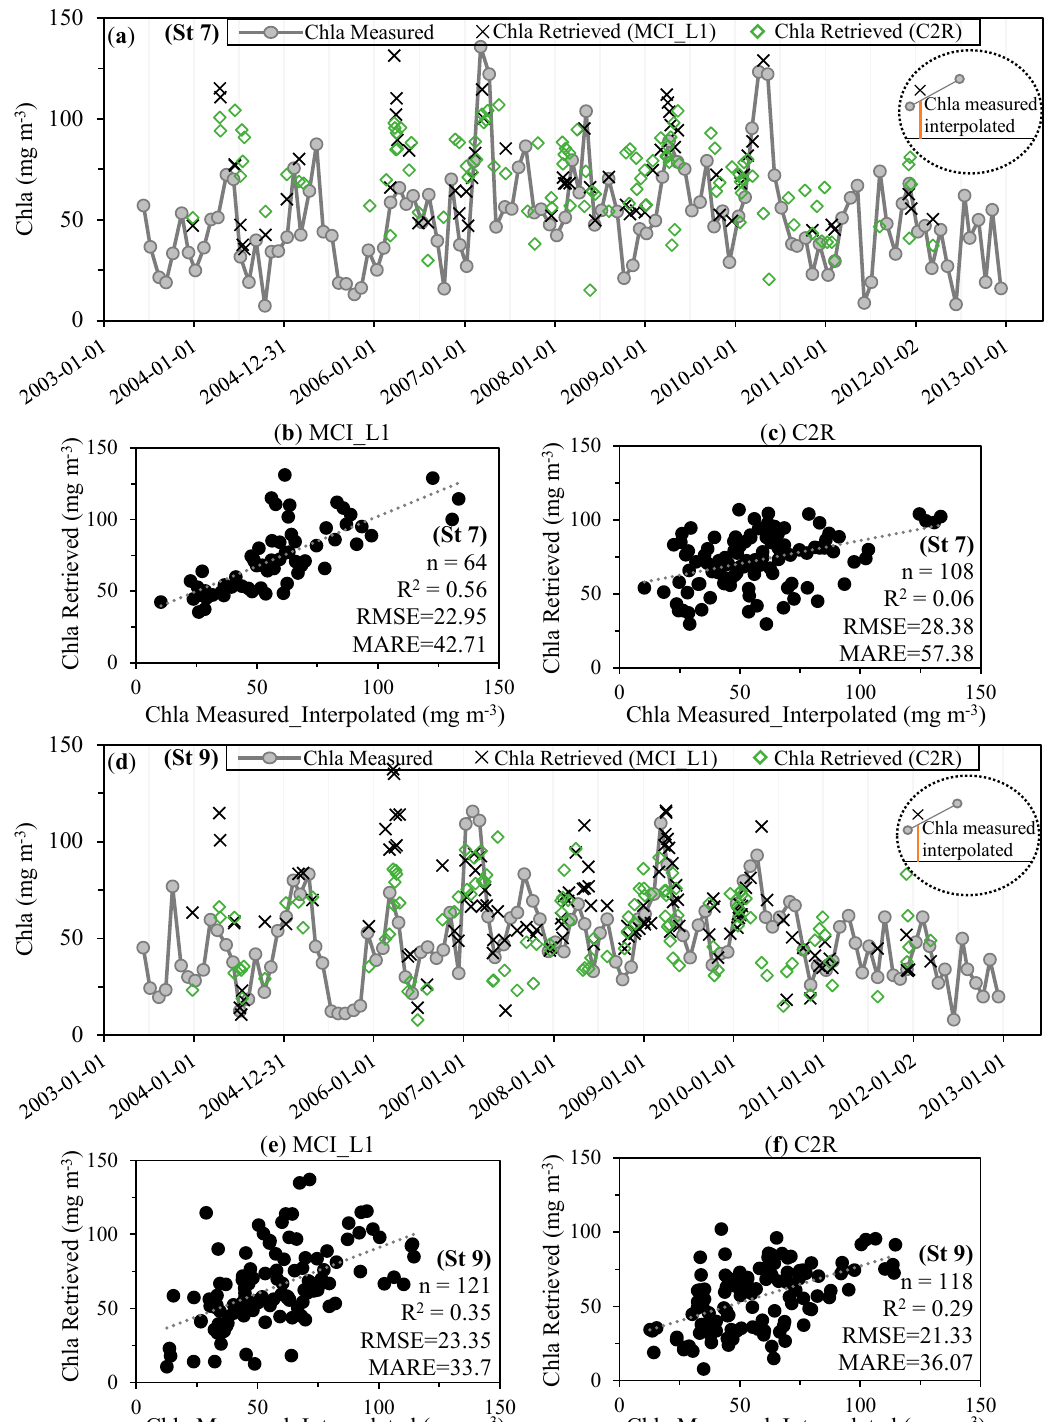
Figure 9. Time series of measured chlorophyll-a (Chla) versus retrieved Chla from MCI_L1 and C2R processors at ( a ) station 7 (St 7) and ( d ) station 9 (St 9). Scatter plot of measured interpolated Chla (linear interpolation was used to estimate measured Chla at the same day of available satellite data) versus retrieved Chla ( b ) MCI_L1 at St 7; ( c ) C2R at St 7; ( e ) MCI_L1 at St 9; and ( f ) C2R at St 9. n stands for the number of match-ups. The units of RMSE and MARE are in mg∙m −3 and %, respectively.